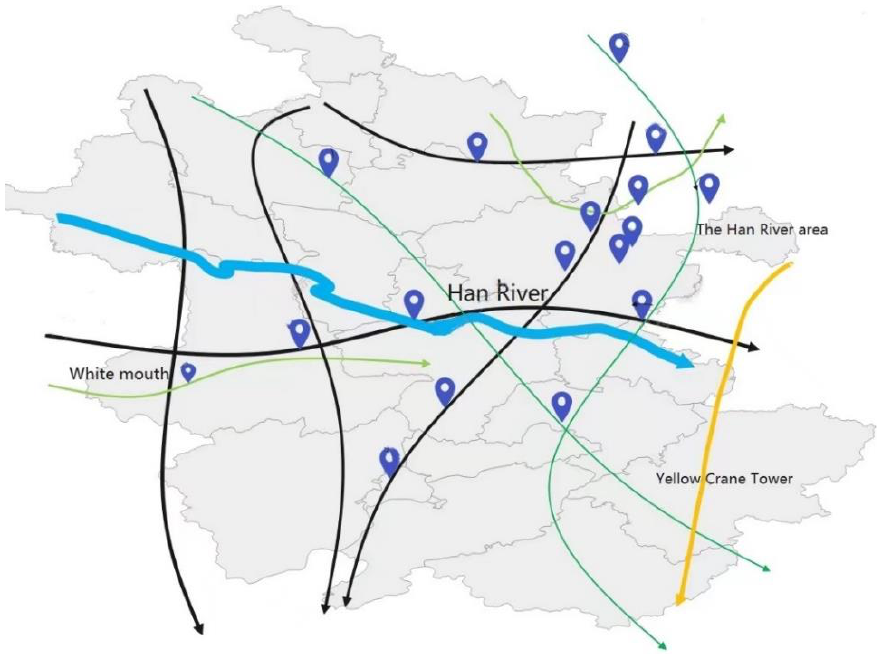
Figure 4. Distribution map of grade A hospitals in